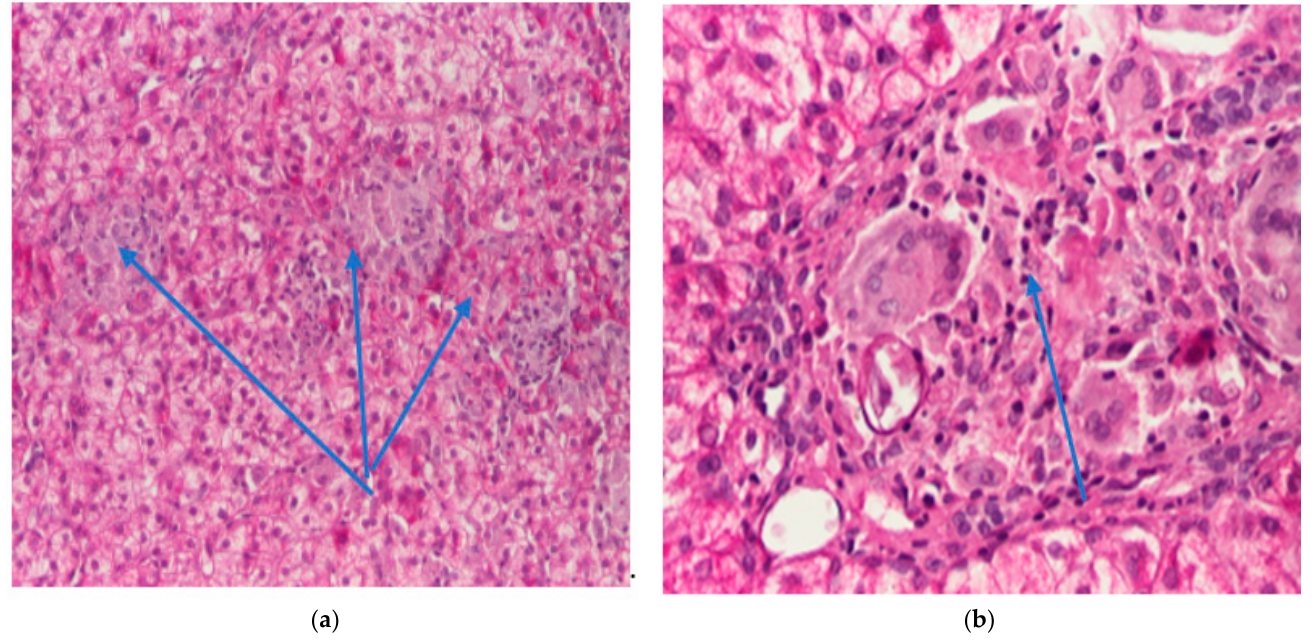
Figure 5. ( a ): PAS coloration ×100; ( b ): PAS coloration ×200. Liver tissue showing chronic giant cell granulomatous hepatitis (blue arrows) (personal collection, St. Mary Emergency Children’s Hospital, Iasi).